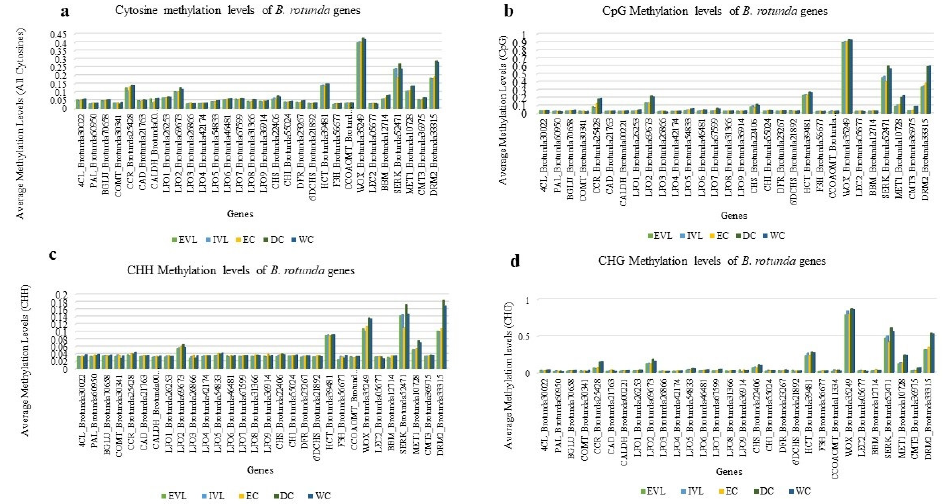
Figure 6. ( a – d ) average methylation levels of DNA methyltransferase-related genes (MET1, CMT3, and DRM2), somatic embryogenesis genes (SERK, BBM, LEC2, and WUS), and genes involved in flavonoid and phenylpropanoid biosynthesis pathways in different samples of B. rotunda ; ex-vitro leaf (EVL), in vitro leaf (IVL), embryogenic callus (EC), dry callus (DC), and watery callus (WC). ( a ) cytosine methylation; ( b ) CpG methylation; ( c ) CHG methylation; ( d ) CHH methylation. CAD, cin-